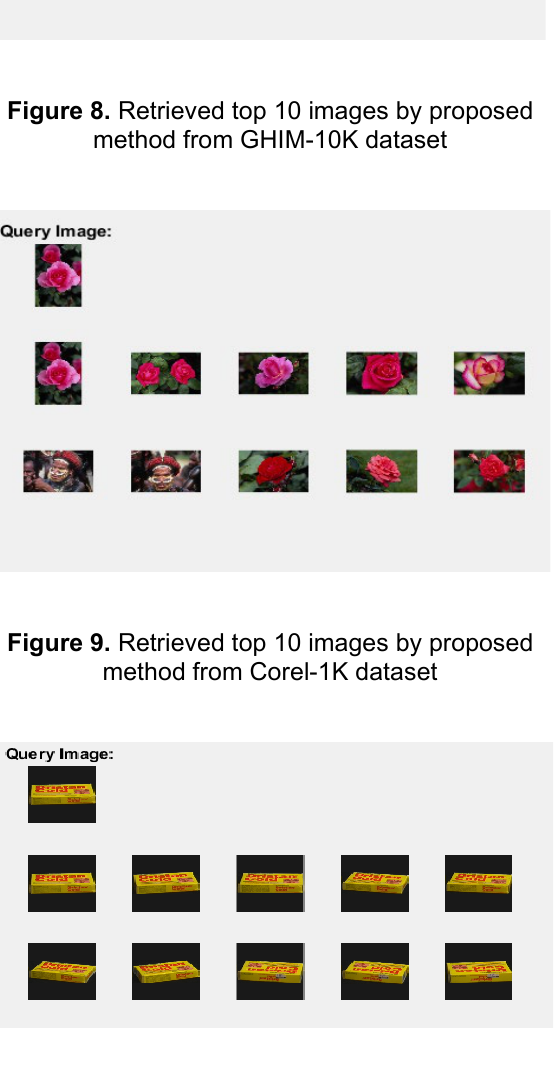
Figure 10. Retrieved top 10 images by proposed method from Coil-100